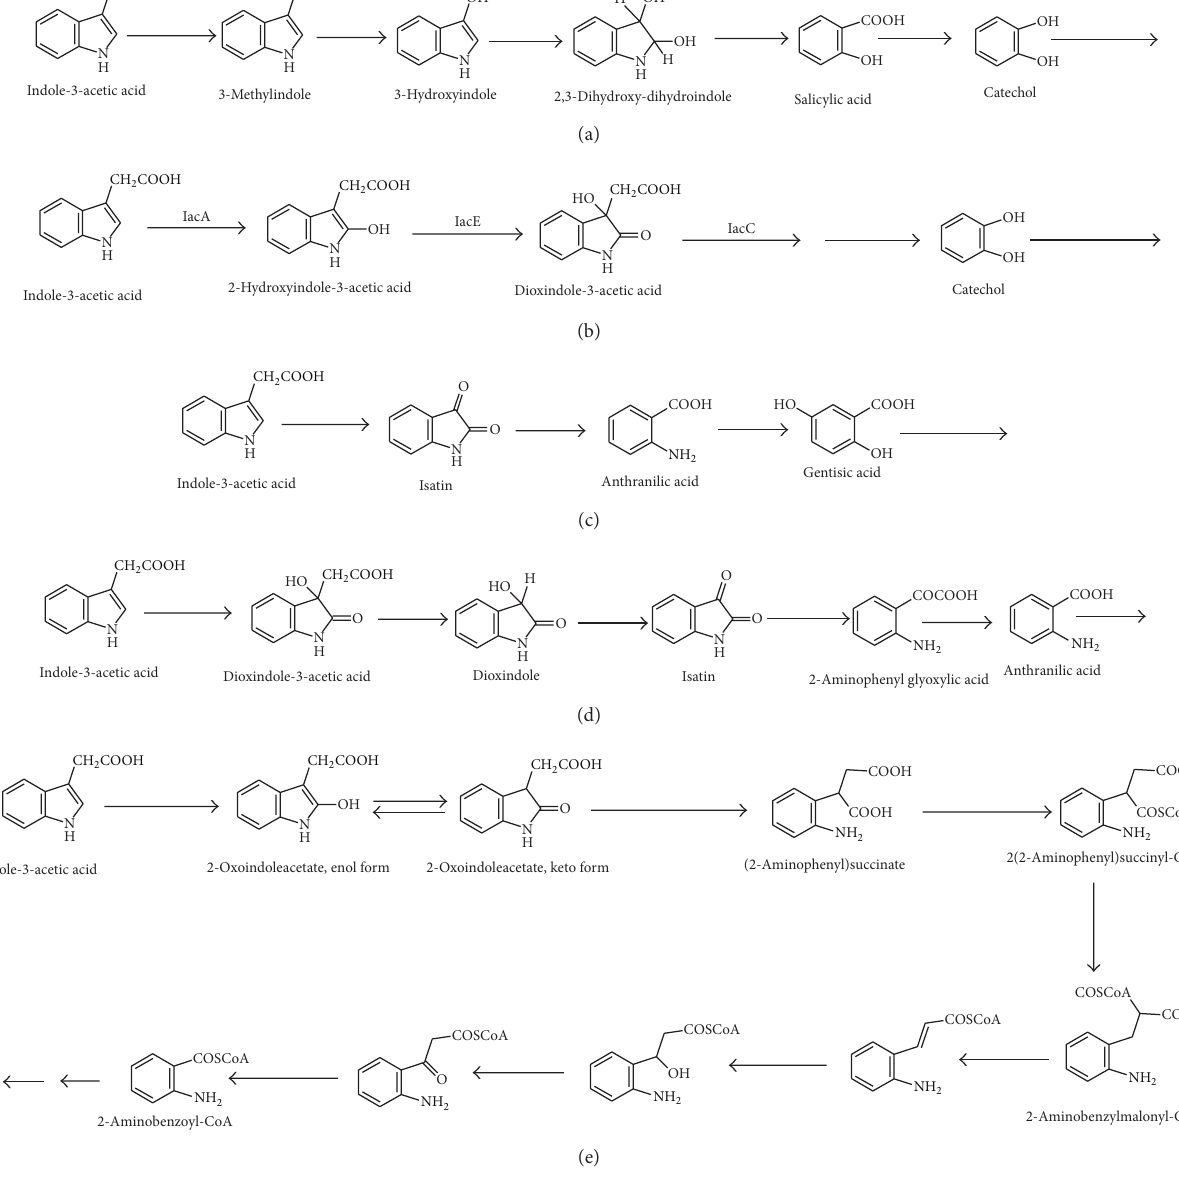
further degradation of indole proceeded via isatin, anthran- ilic acid, and salicylic acid (Figure 7(a)). The enzyme activities for 4-chloroindole dehalogenase and anthranilic acid deam- inase were detected in the crude extract of the 4-chloroin- doles-induced cells of Exiguobacterium sp. PMA, confirm- ing indole and salicylic acid formation in the degradation pathway of 4-chloroindole. Exiguobacterium sp. PMA also degraded 4-chloroindole in sterile and nonsterile soil [28]. The degradation rate was faster in sterile soil than in nonster- ile soil